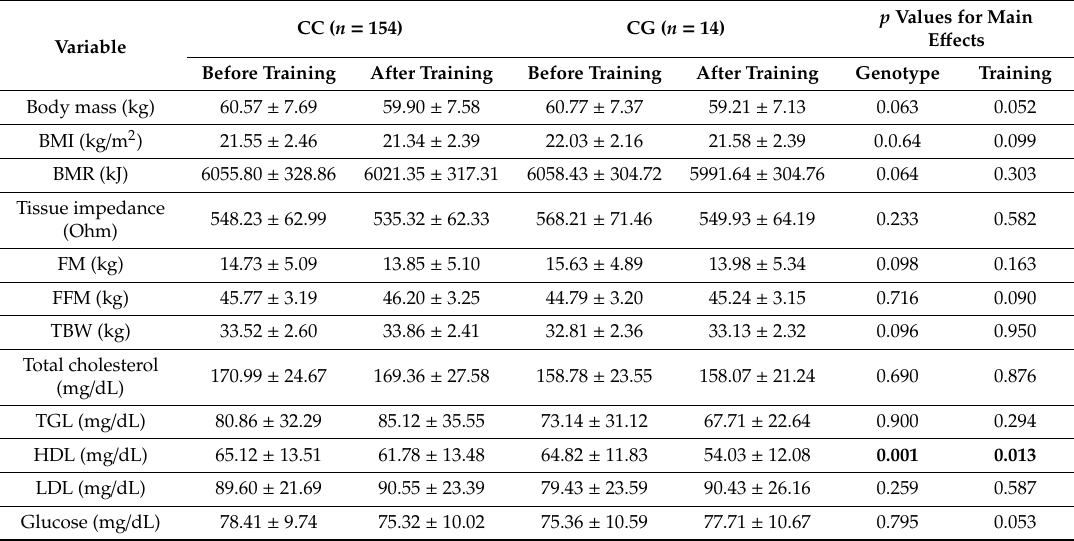
Table 2. The PPARA Leu162Val rs18000206 genotypes and response to